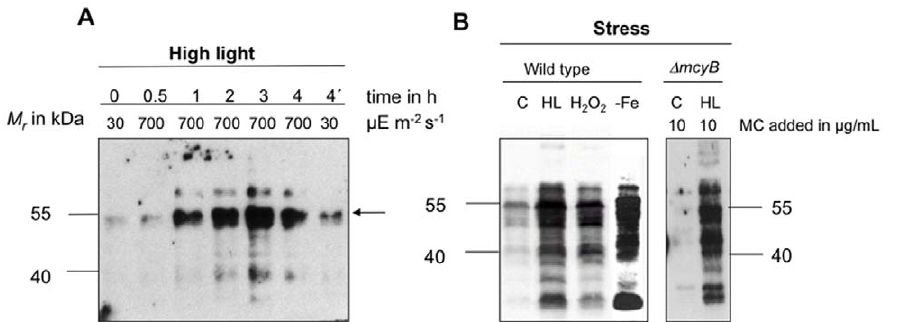
Figure 4. Impact of light and oxidative stress on microcystin binding to proteins. A) Immunoblot analyses of soluble Microcystis protein extracts with an anti-microcystin antibody after high light treatment of 700 m mol photons m 2 2 s 2 1 for up to 4 hours. The irradiation time of the individual samples is indicated. The sample 4 9 h was irradiated with high light for three hours and subsequently transferred to low light for one hour. B) Immunoblot analysis of a low light adapted culture (C) that was treated for 4 hours with 700 m mol photons m 2 2 s 2 1 high light (HL), 10 m M H 2 O 2 or in parallel grown under low light in the absence of iron (-Fe). Immunoblot analysis of a low light adapted culture of the D mcyB mutant and a culture treated for three hours with high light (700 m mol photons m 2 2 s 2 1 ) after microcystin addition.